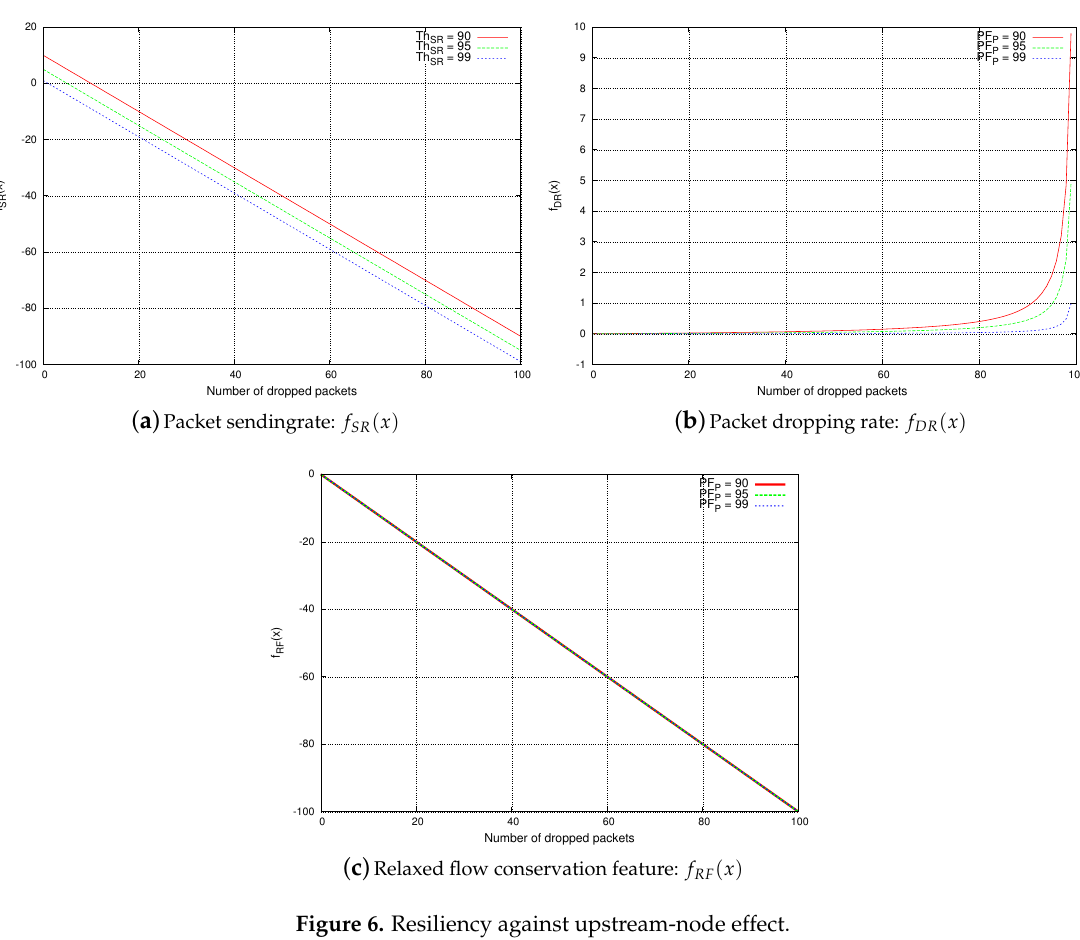
Figure 6. Resiliency against upstream-node